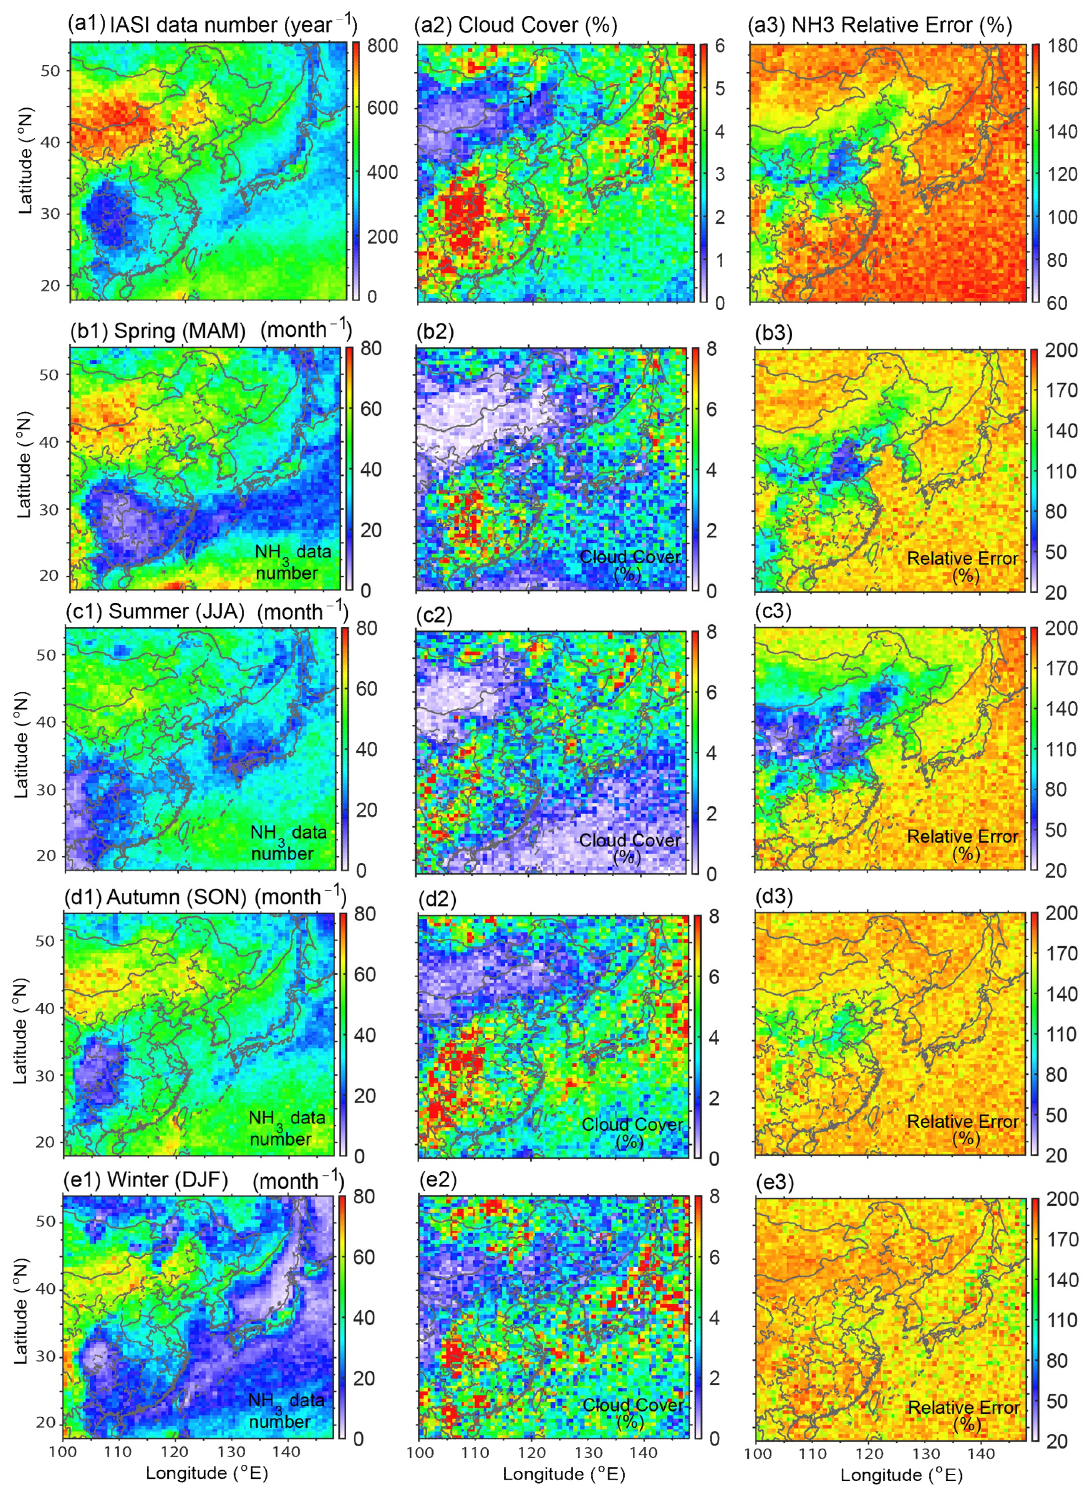
Figure A1. Horizontal distributions of NH 3 data number per grid ( a1 , b1 , c1 , d1 , e1 ), averaged cloud cover (%, a2 , b2 , c2 , d2 , e2 ), and ( c ) relative error (%, a3 , b3 , c3 , d3 , e3 ) over East Asia for the whole year ( a1 – a3 ) and each season ( b1 – e3 ) of 2014.